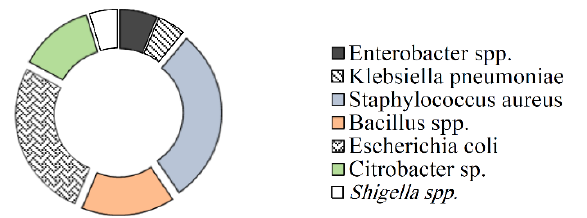
Fig. 1. Distribution of bacterial